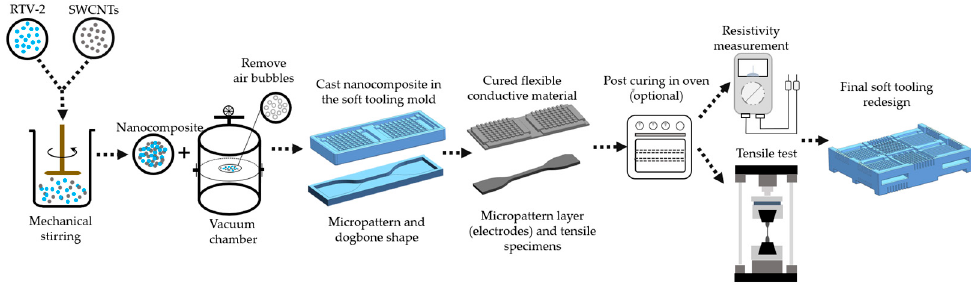
Figure 3. Schematic illustration of the assessment process for nanocomposites RTV ‐ 2/SWCNTs.